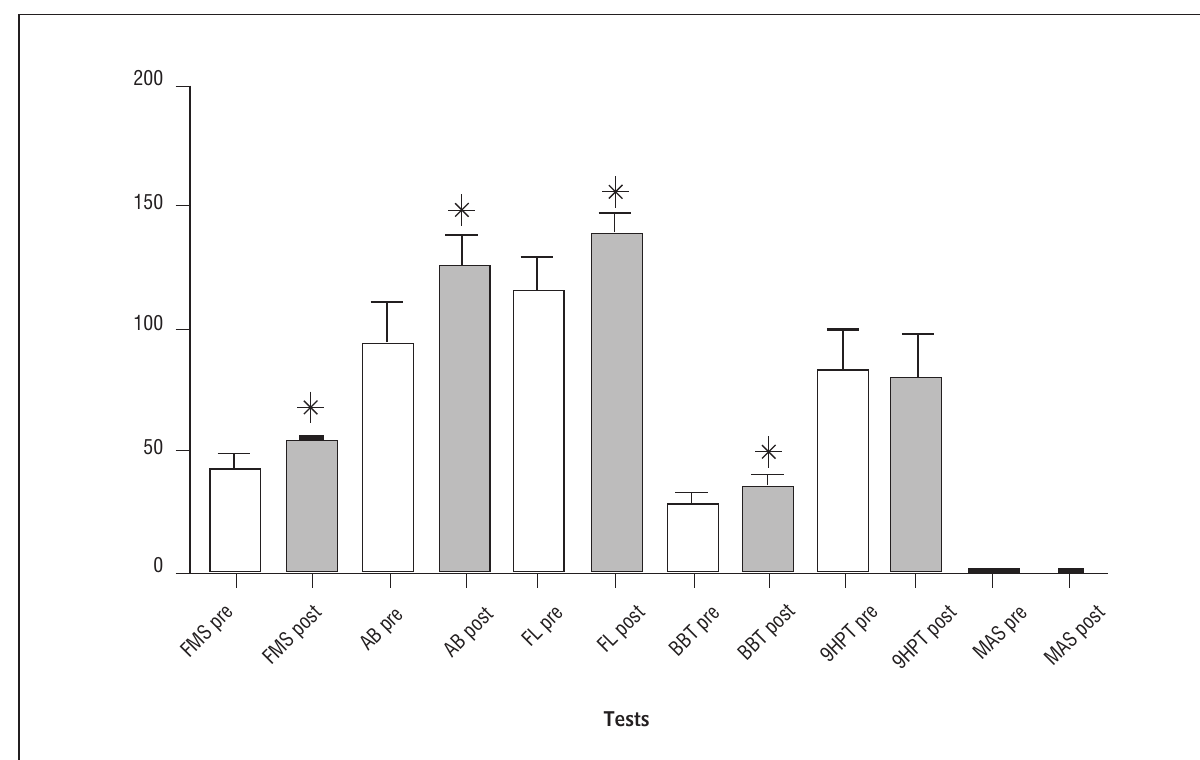
Figure 2 - Main tests used of study Note: FMS = Fugl-Meyer Scale (UL session); AB = Shoulder abduction goniometry; FL = Shoulder fl exion goniometry; BBT = Box and Blocs Test; 9HPT = Nine Hole and Peg Test; MAS = Modi fi ed Ashworth Scale. p ≤